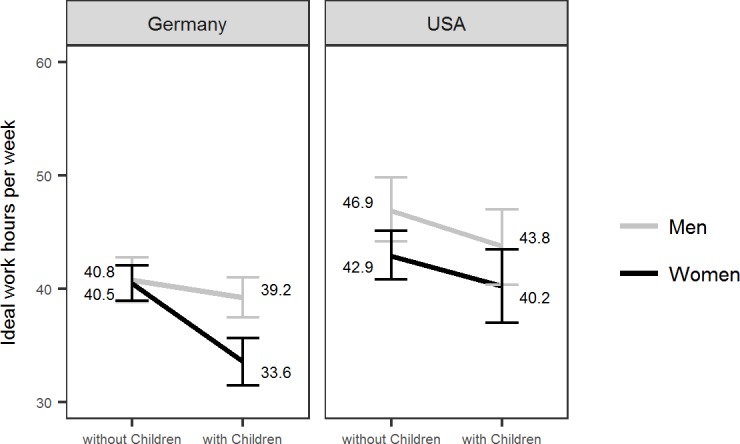
Ideal work hours of German and U.S. early career researchers as a function of gender and parenthood.Figure depicts the empirical (not imputed) means. Errorbars indicate 95% bootstrap confidence intervals.